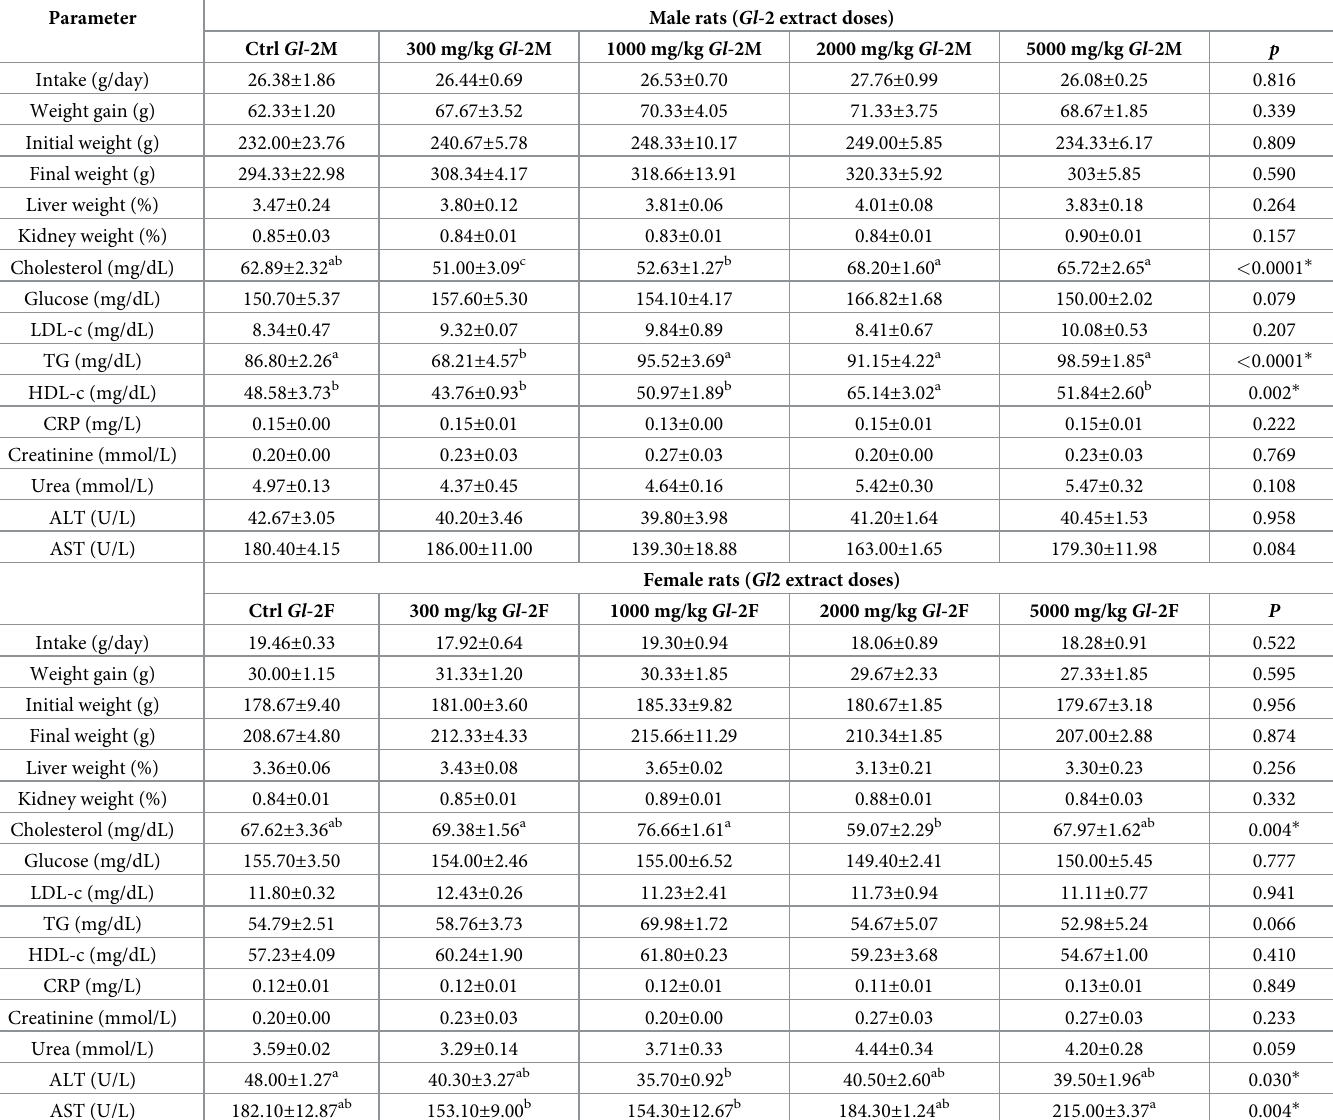
Table 2. Average data from food intake, weight gain, liver and kidney weight, and serum biochemical parameters of male (M) and female (F) Wistar rats studied, after 14 experimental days. Rats were fed with the control diet and different doses of the standardized Gl -2 extract from Ganoderma lucidum .